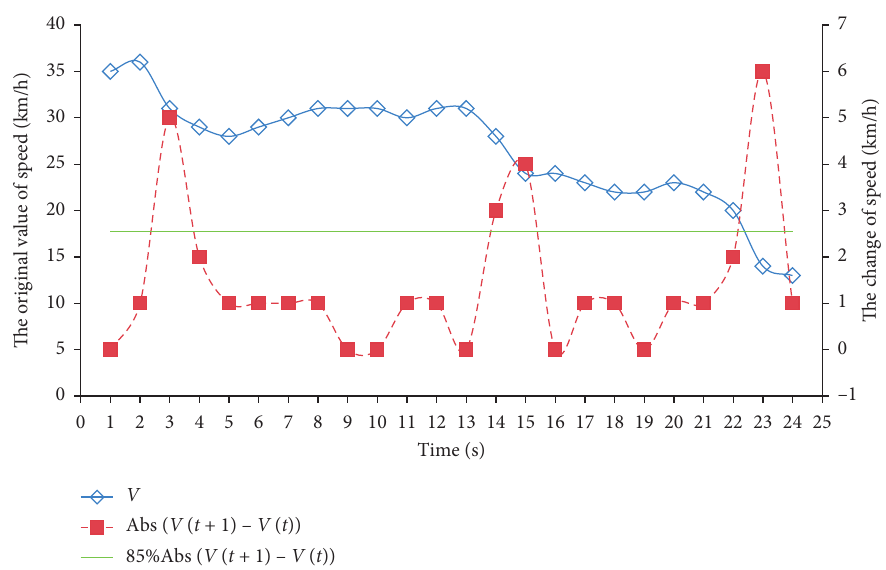
Figure 1: Illustration of the fluctuation of vehicle velocity (taking 200 meters as an